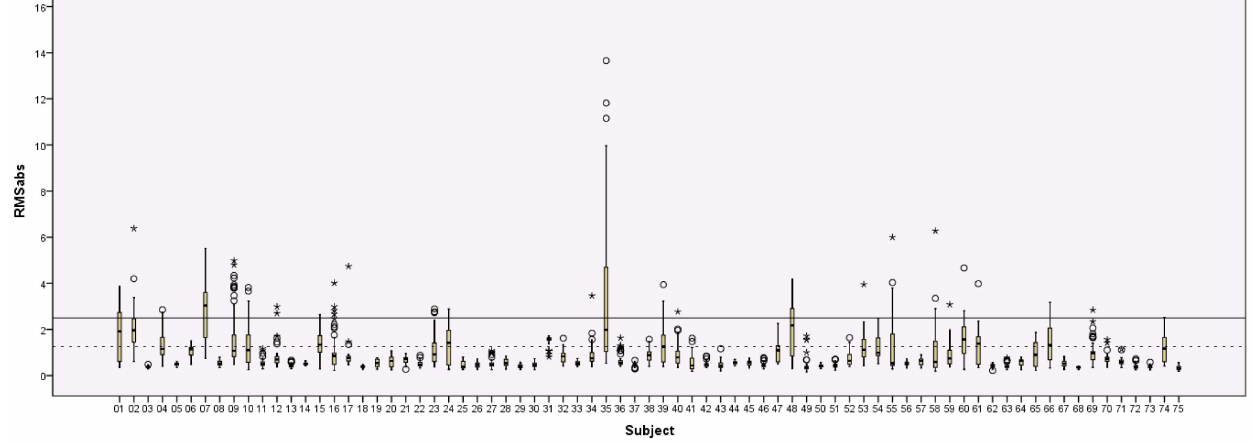
Figure 1. Boxplots of the RMS abs displacement over the time-series of the DTI scans. Boxplots of the absolute root mean squared motion are shown for each of the 75 children that underwent DTI scanning. Continuous line = width of one voxel, dotted line = half a voxel’s width.